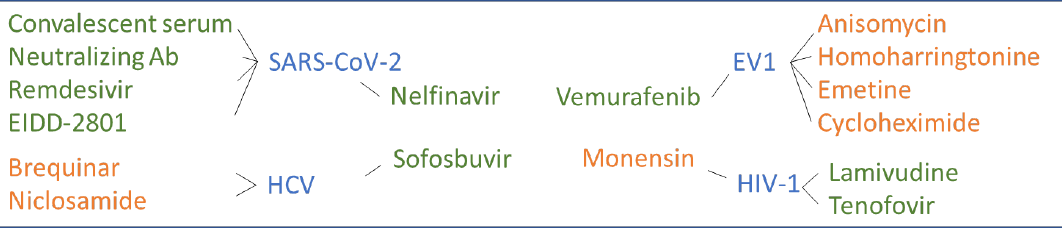
Figure 7. Synergistic virus- (green) and host- (orange) targeting drug combinations identified in this study. HCV: hepatitis C virus.